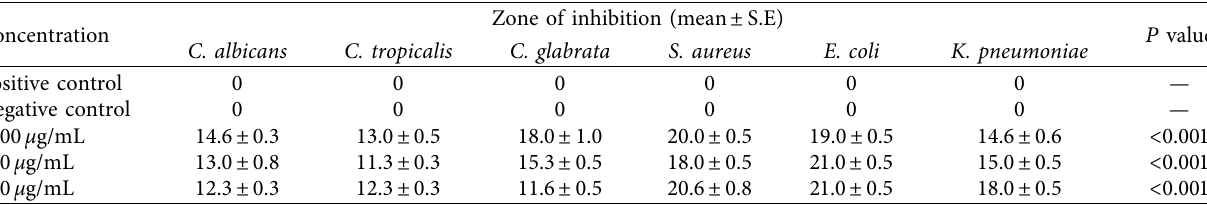
Zone of inhibition (mean ±